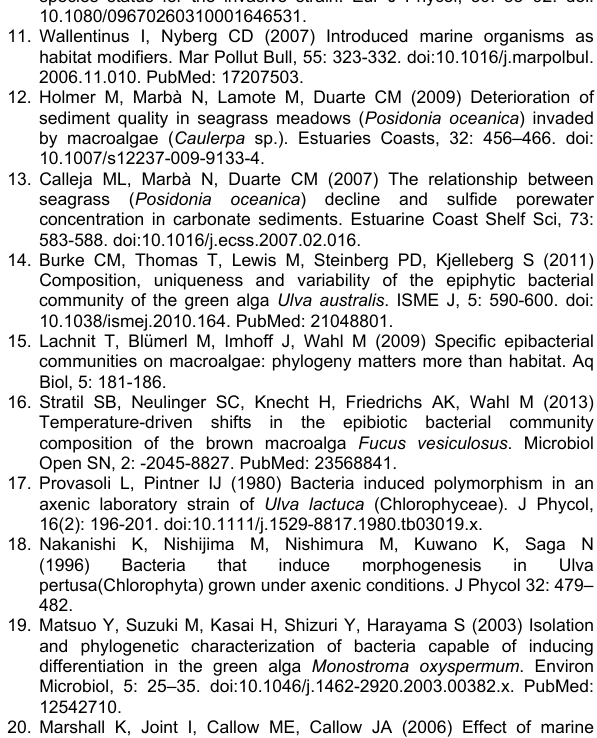
Table S2. Results of samples’ quality filtering and α- diversity analyses. Placehold legend. Remove.